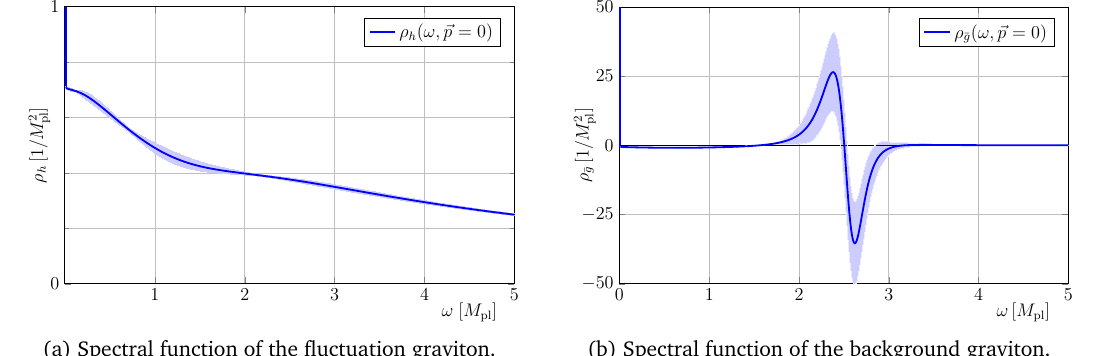
Figure 1: Spectral functions of the fluctuation and background graviton. The shaded areas constitute the estimated error of the reconstruction. The fluctuation graviton spectral function is strictly positive, which may be important for the unitarity of asymptotically safe gravity. In turn, we show that the background graviton spectral function has a vanishing spectral weight and hence positive and negative parts. For more details see Sec.5.2 and